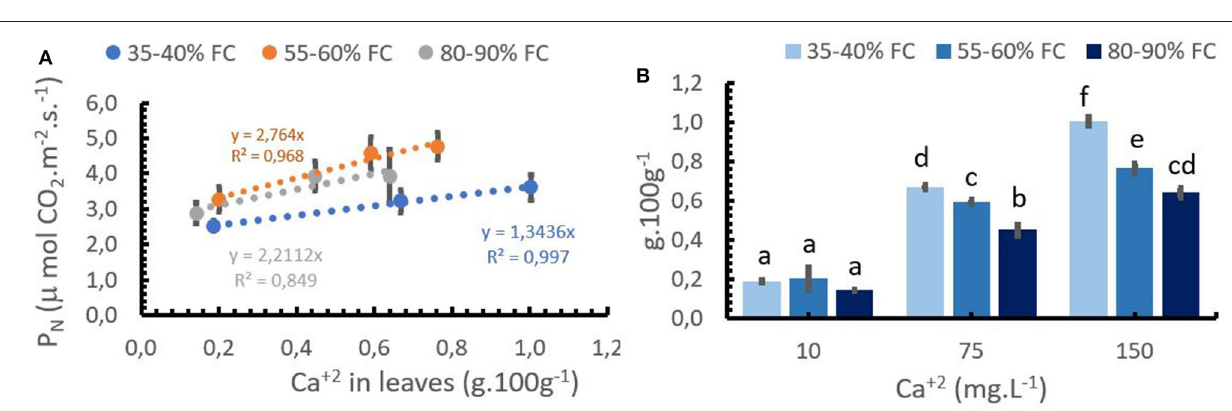
FIGURE 3 | Relationship between Ca + 2 concentration in the leaves and photosynthetic activity –( P N , A ), and Ca + 2 application rates and leaf Ca + 2 concentrations at 3 soil moisture levels (B) . Bars represent the mean values for each of the replicates ± standard error. Different letters represent statistically significant differences among the treatments ( P < 0.05, LSD